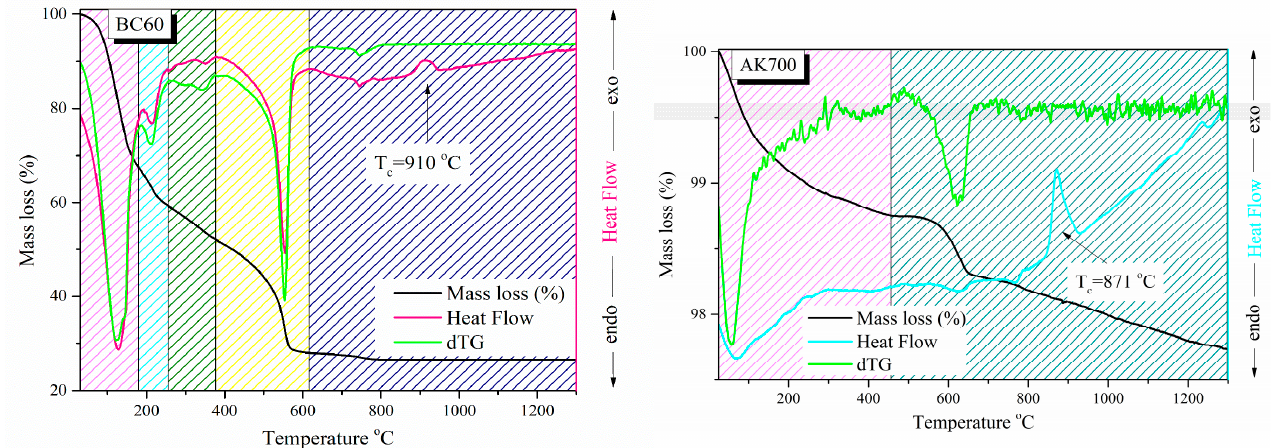
Figure 7. Heat flow and mass loss curves of samples after heating to 60 and 700 °C (BC60 and BC700, respectively).